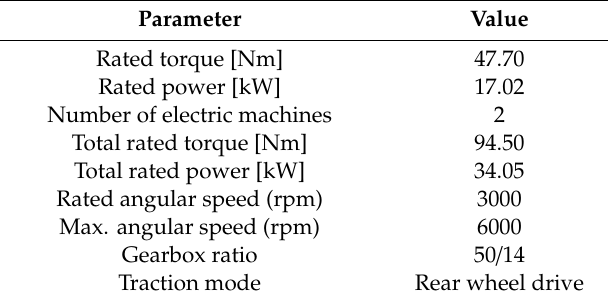
Table 2. Powertrain parameters of ISEC’s race car.